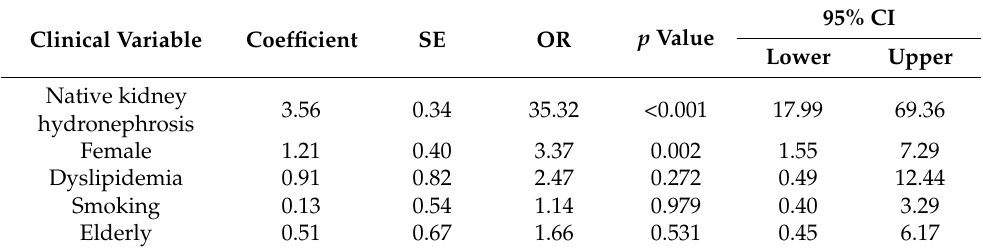
Table 3. Multivariate logistic regression analysis for the association between UTUC and clinical variables. Clinical